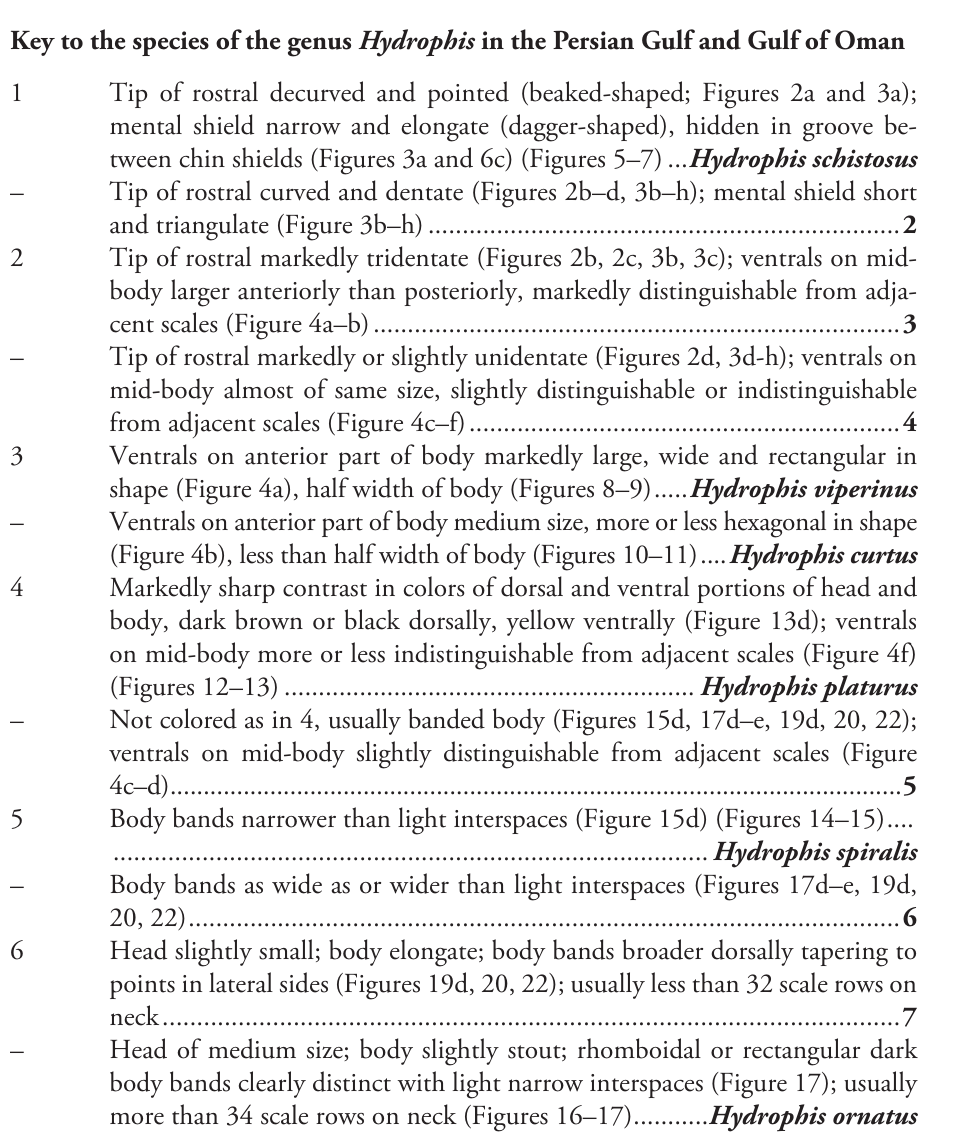
Key to the species of the genus Hydrophis in the Persian Gulf and Gulf of Oman 1 Tip of rostral decurved and pointed (beaked-shaped; Figures 2a and 3a); mental shield narrow and elongate (dagger-shaped), hidden in groove be- tween chin shields (Figures 3a and 6c) (Figures 5–7) ... Hydrophis schistosus – Tip of rostral curved and dentate (Figures 2b–d, 3b–h); mental shield short and triangulate (Figure 3b–h) ..................................................................... 2 2 Tip of rostral markedly tridentate (Figures 2b, 2c, 3b, 3c); ventrals on mid- body larger anteriorly than posteriorly, markedly distinguishable from adja- cent scales (Figure 4a–b) ............................................................................. 3 – Tip of rostral markedly or slightly unidentate (Figures 2d, 3d-h); ventrals on mid-body almost of same size, slightly distinguishable or indistinguishable from adjacent scales (Figure 4c–f) ............................................................... 4 3 Ventrals on anterior part of body markedly large, wide and rectangular in shape (Figure 4a), half width of body (Figures 8–9) ..... Hydrophis viperinus – Ventrals on anterior part of body medium size, more or less hexagonal in shape (Figure 4b), less than half width of body (Figures 10–11) .... Hydrophis curtus 4 Markedly sharp contrast in colors of dorsal and ventral portions of head and body, dark brown or black dorsally, yellow ventrally (Figure 13d); ventrals on mid-body more or less indistinguishable from adjacent scales (Figure 4f) (Figures 12–13) ............................................................ Hydrophis platurus – Not colored as in 4, usually banded body (Figures 15d, 17d–e, 19d, 20, 22); ventrals on mid-body slightly distinguishable from adjacent scales (Figure 4c–d) .............................................................................................................. 5 5 Body bands narrower than light interspaces (Figure 15d) (Figures 14–15) .... ....................................................................................... Hydrophis spiralis – Body bands as wide as or wider than light interspaces (Figures 17d–e, 19d, 20, 22) ........................................................................................................ 6 6 Head slightly small; body elongate; body bands broader dorsally tapering to points in lateral sides (Figures 19d, 20, 22); usually less than 32 scale rows on neck ........................................................................................................... 7 – Head of medium size; body slightly stout; rhomboidal or rectangular dark body bands clearly distinct with light narrow interspaces (Figure 17); usually more than 34 scale rows on neck (Figures 16–17) ........... Hydrophis